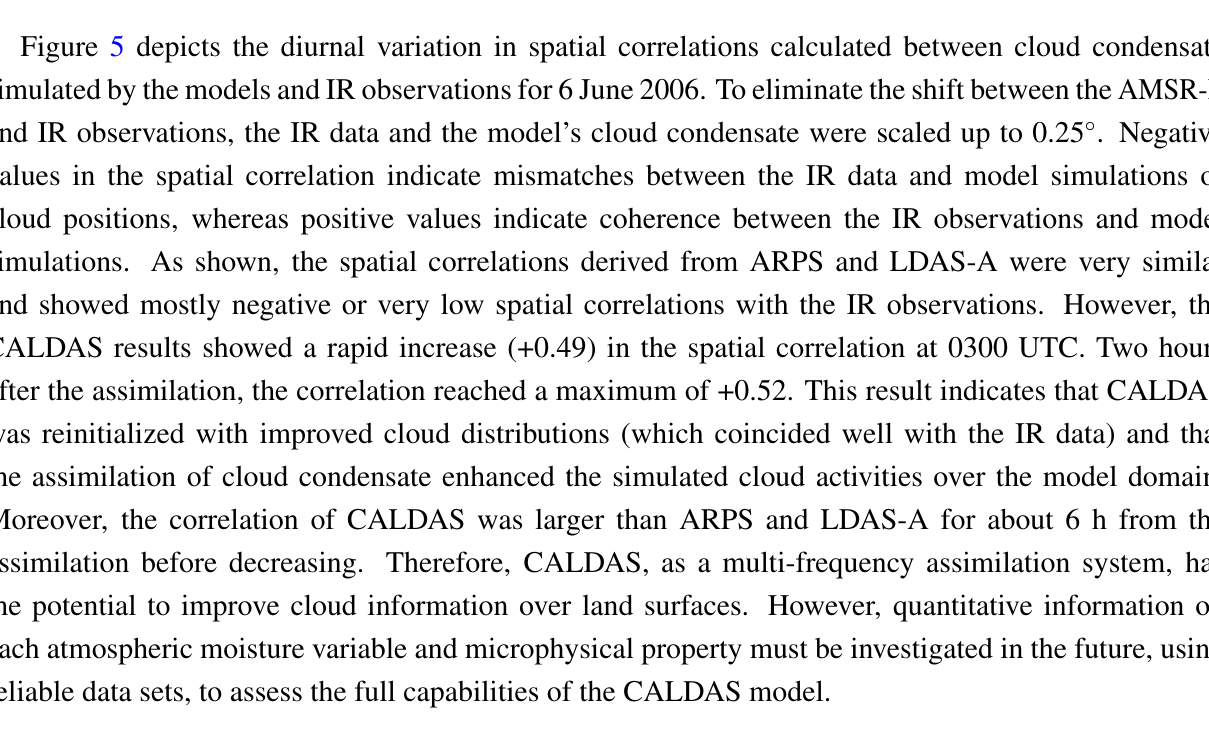
Figure 5. Hourly variation of spatial correlations calculated from model simulated cloud top temperatures and IR cloud top temperatures for 6 June